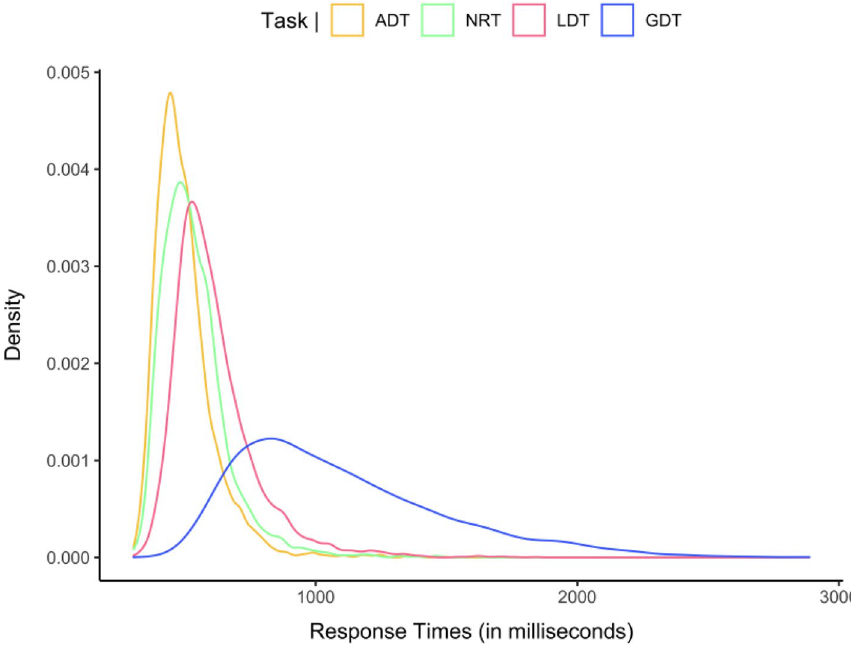
Figure 3. Distribution of RTs for correct “yes” responses in each task. NRT non-reading task, ADT alphabetic decision task, LDT lexical decision task, GDT grammatical decision task.